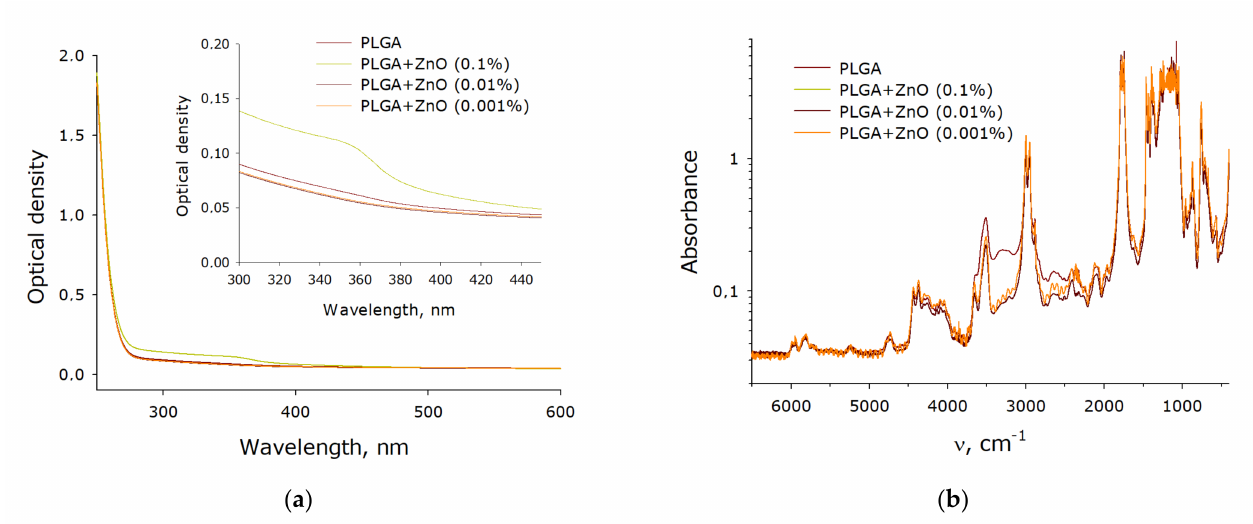
Figure 6. Spectral properties of a nanocomposite polymer material containing PLGA and ZnO nanoparticles. ( a ) Absorption UV-Vis spectrum of composite polymer materials with different filling with zinc oxide nanoparticles. ( b ) FTIR spectrum of composite polymer materials with different filling with zinc oxide